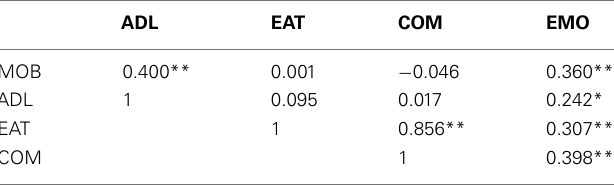
Table 4 | Correlations between areas at the first evaluation.